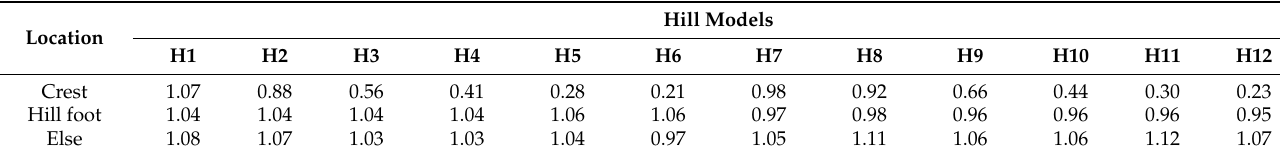
Table 4. Maximum of M t,max for hill models.